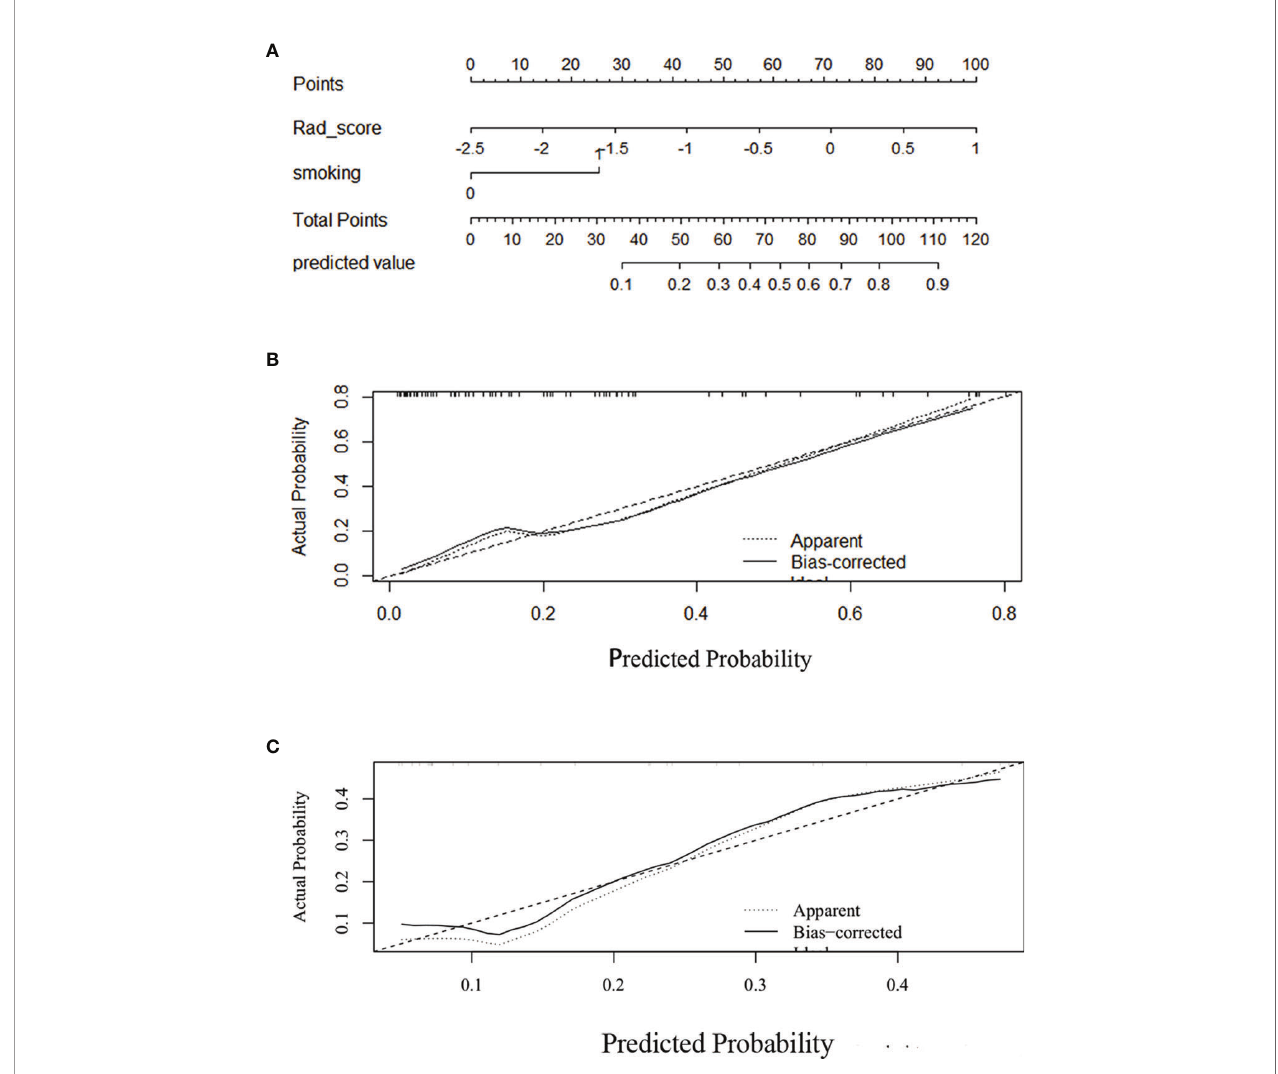
FIGURE 5 | Development and performance of a nomogram. (A) Nomogram based on rad-score and clinical factors (smoking history). Calibration curves (B, C) of the nomogram in the training set. The horizontal axis is the predicted incidence of the tumor microenvironment immune type (TMIT)-I tumors. The vertical axis is the observed incidence of the TMIT-I tumors. The diagonal line is the reference line, indicating that the predicted value is equal to the actual value. The prediction results and diagonals were basically coincident, indicating that the prediction results were